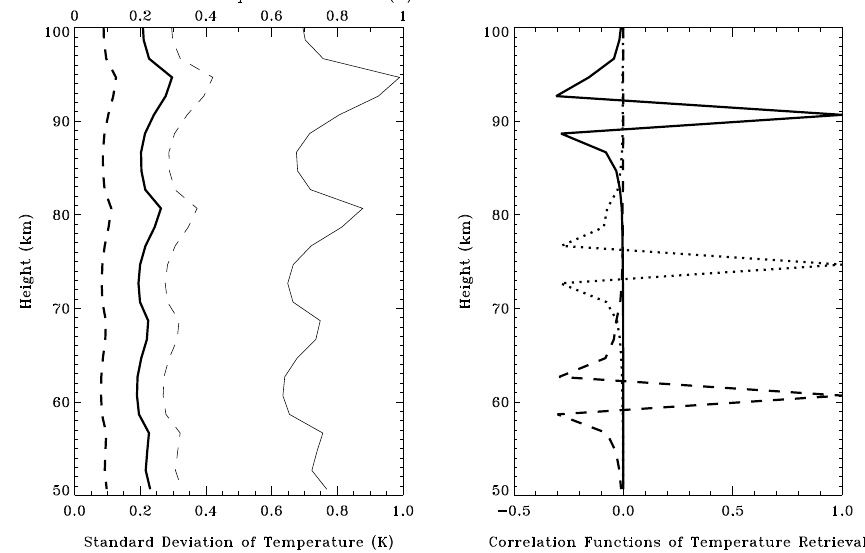
Fig. 4. Temperature error results for DD scenario (bold lines) and SD sce- nario (light lines). Left panel: abso- lute (solid lines) and relative (dashed lines) standard deviation of temperature retrieval errors. Right panel: correla- tion functions for three representative heights, ∼ 60 km (dashed line), ∼ 75 km (dotted line), and ∼ 90 km (solid